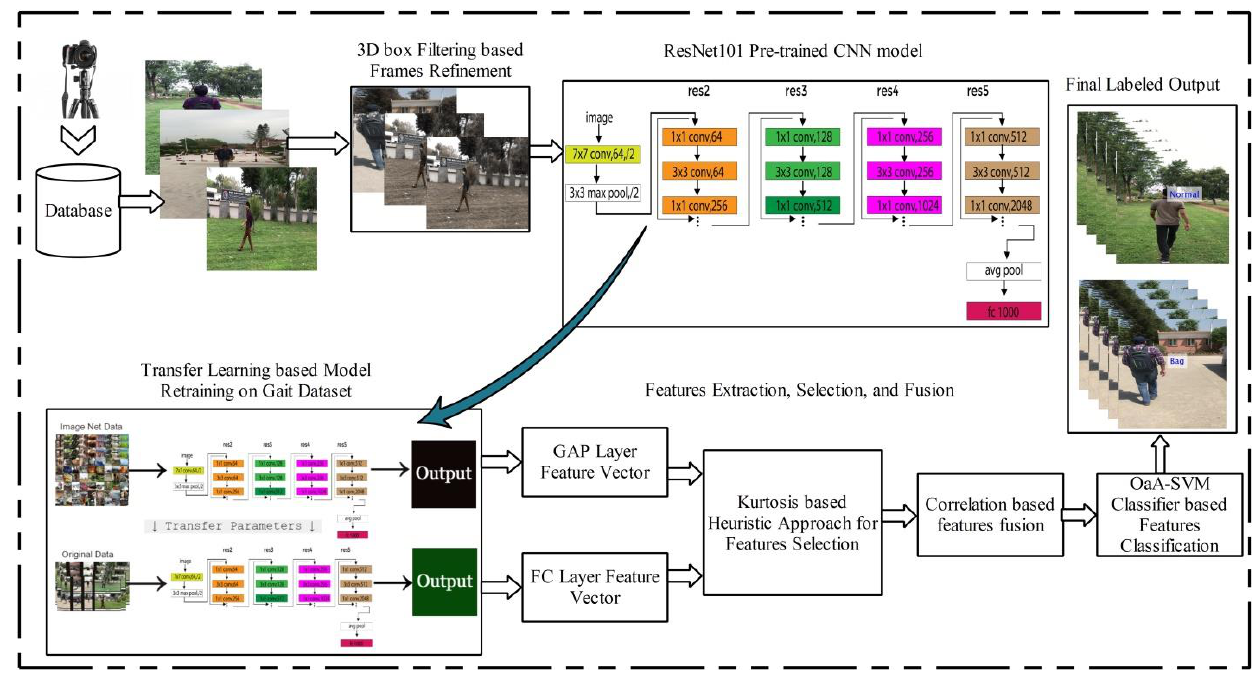
Figure 2. Proposed architecture of real-time human gait recognition using deep learning.